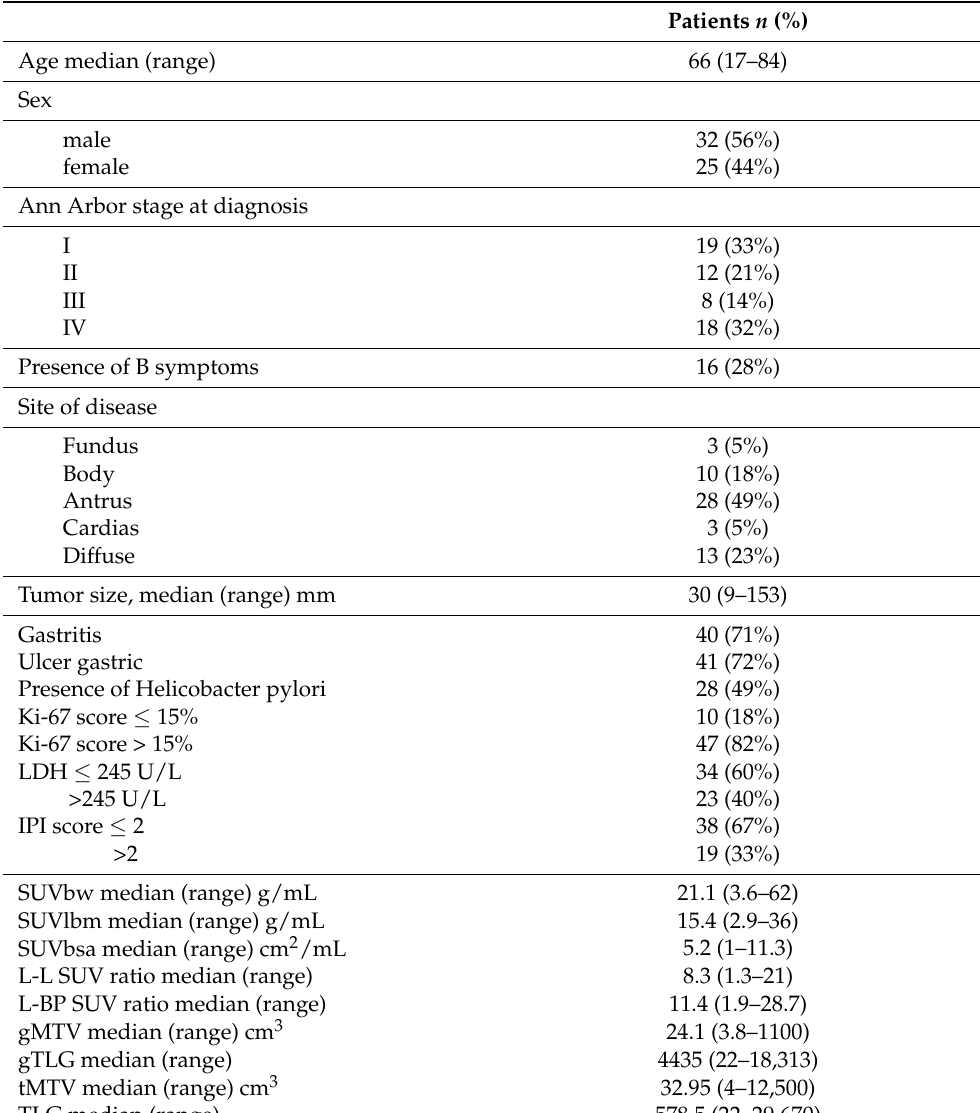
Table 1. The main features of our